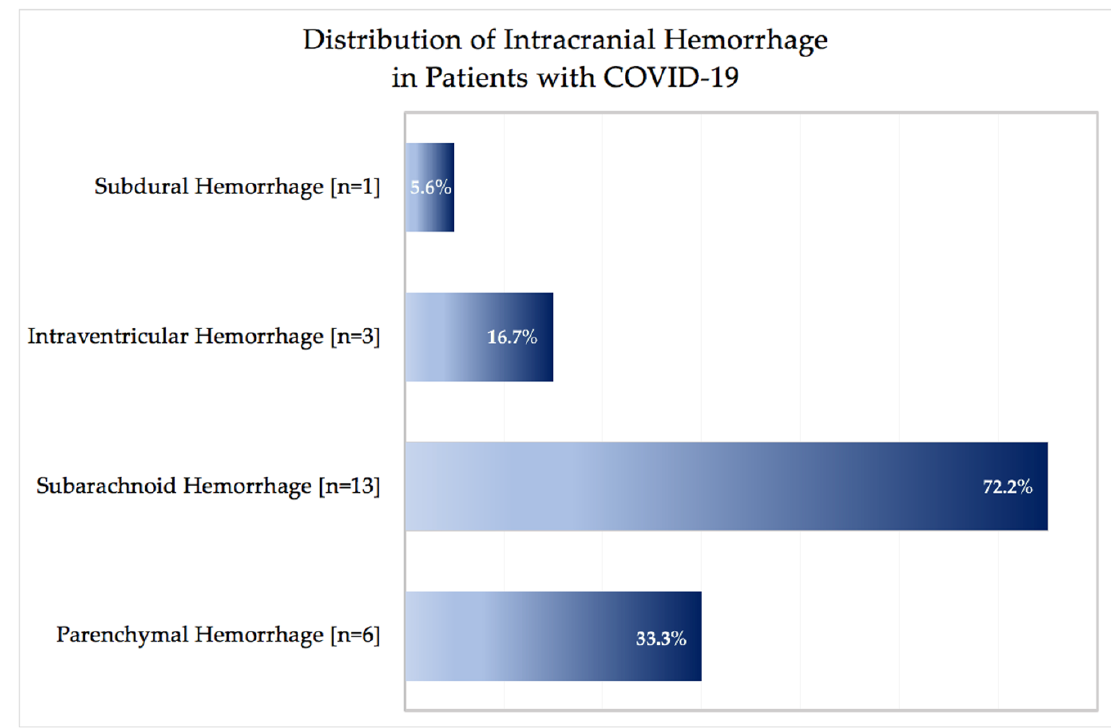
Figure 1. Distribution of intracranial hemorrhage in patients with Coronavirus Disease 2019. Legend: Distribution of intracranial hemorrhage events in patients with Coronavirus Disease 2019 (COVID-19). The distribution of the intracerebral hemorrhage type is presented in relation to all patients ( n = 18). Table 2. Neuroimaging characteristics of patients with COVID-19.